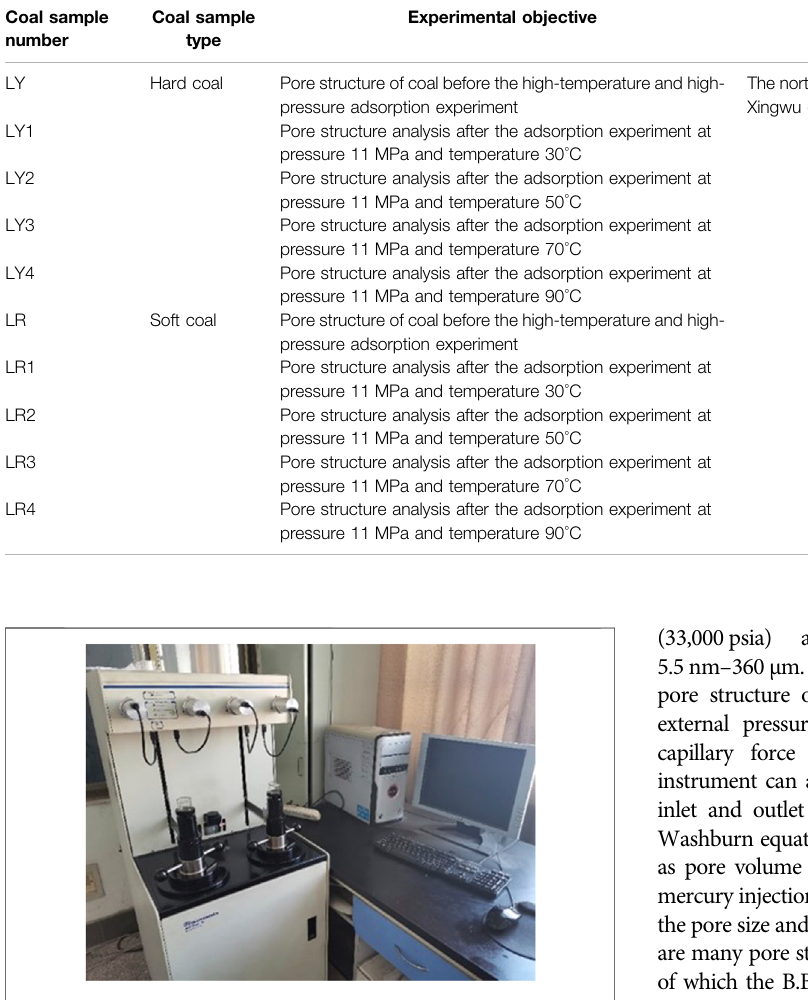
FIGURE 2 | Mercury